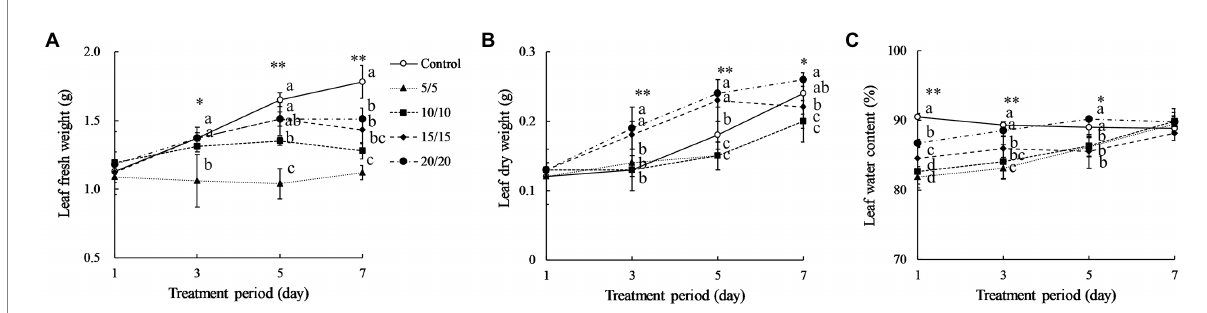
FIGURE 2 Amaranth leaf fresh weight (A) , dry weight (B) , and leaf water content (C) after treatment with different short-term RZTs for different periods (Experiment 1). Vertical bars indicate the standard error ( n = 4). Means were compared using Tukey’s honestly significant difference (HSD) at a significance level at * p < 0.05 and ** p <